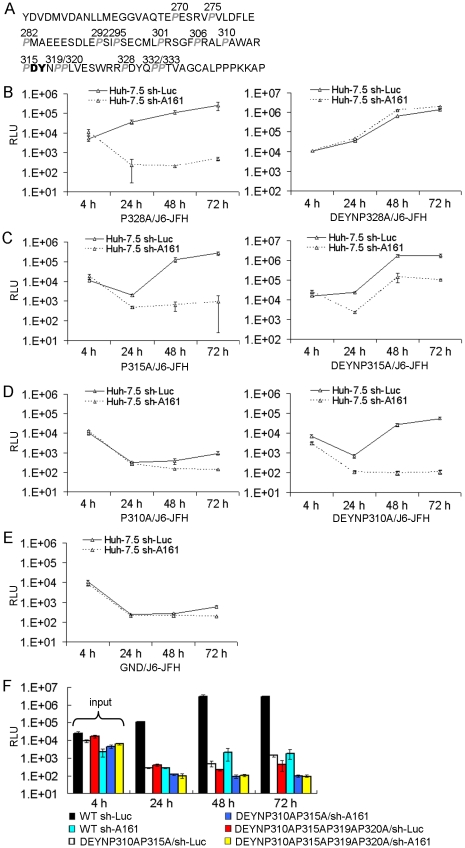
Putative proline substrates of CyPA in NS5A domain II.(A) Sequence of NS5A domain II. Each proline was changed to alanine in both WT and the DEYN background, using the J6-JFH genome. Mutant RNAs were electroporated into both Huh-7.5 sh-Luc and sh-A161 cell lines, and luciferase assays were performed at the indicated time points. The prolines were grouped into three categories according to phenotype. Representative replication kinetics of the mutants are shown in (B) for group I, (C) for group II and (D) for group III. The replication profiles of a GND replication defective mutant is shown in (E). (F) DEYN mutations fail to alleviate the lethal phenotype of double (P310AP315A) or quadruple prolines mutants. Error bars in (B), (C), (D), (E), and (F) represent standard derivations of two to three independent experiments.